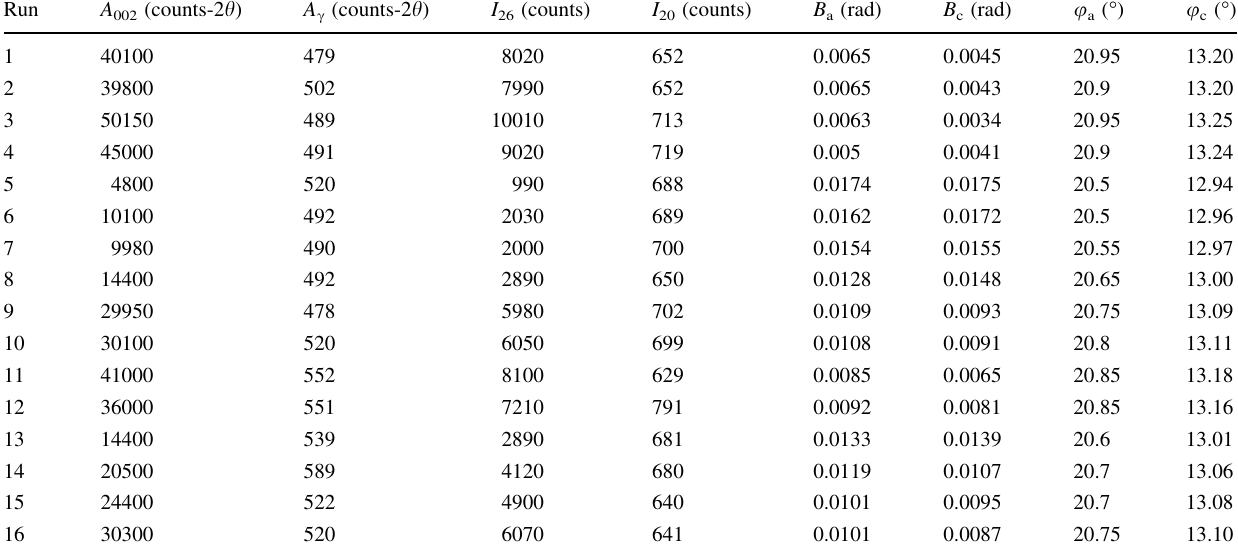
Table 2 The results of XRD readouts for the designed